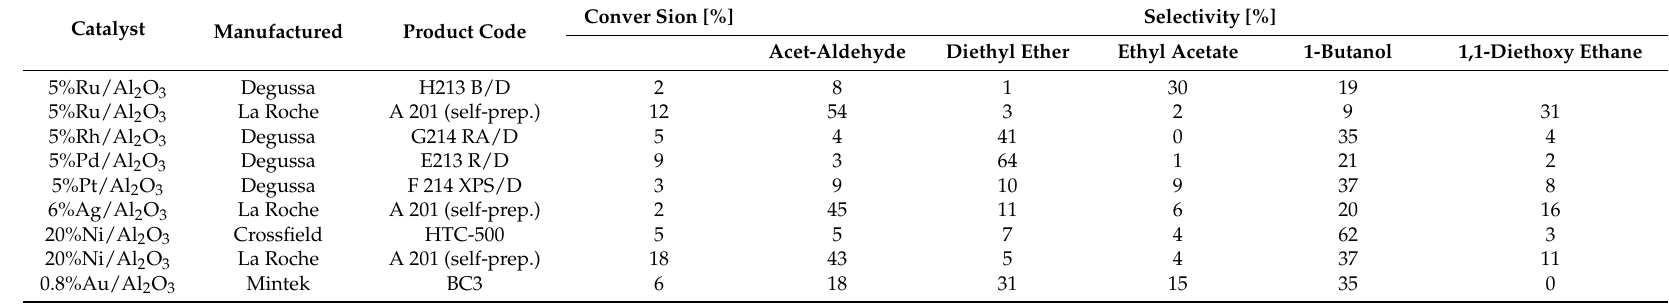
Table 3. One-pot liquid-phase catalytic process for ethanol conversion to 1-butanol over alumina supported with Ru, Rh, Pd, Pt, Au, Ag and Ni catalysts [187].